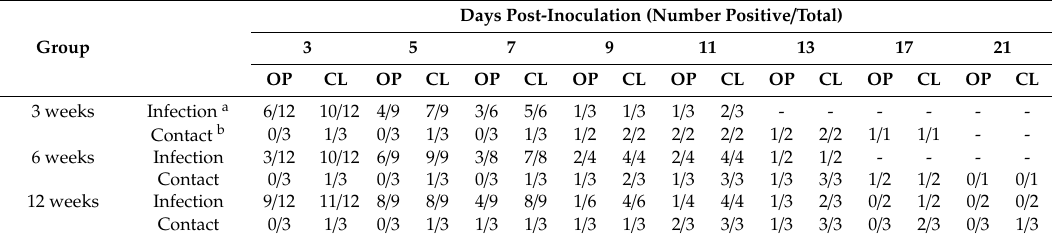
Table 3. Virus shedding of the GZ08 virus from oropharyngeal and cloacal swabs in 3-, 6-, and 12-week-old